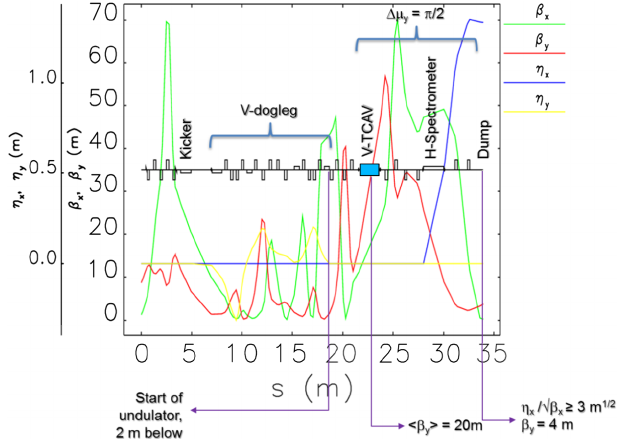
FIG. 9. Linear optics functions along the off-axis diagnostic line. Position of elements along the lattice and optics constraints for optimum diagnostic resolution are shown. The starting point is end of the CA, the beam moves from left to right.